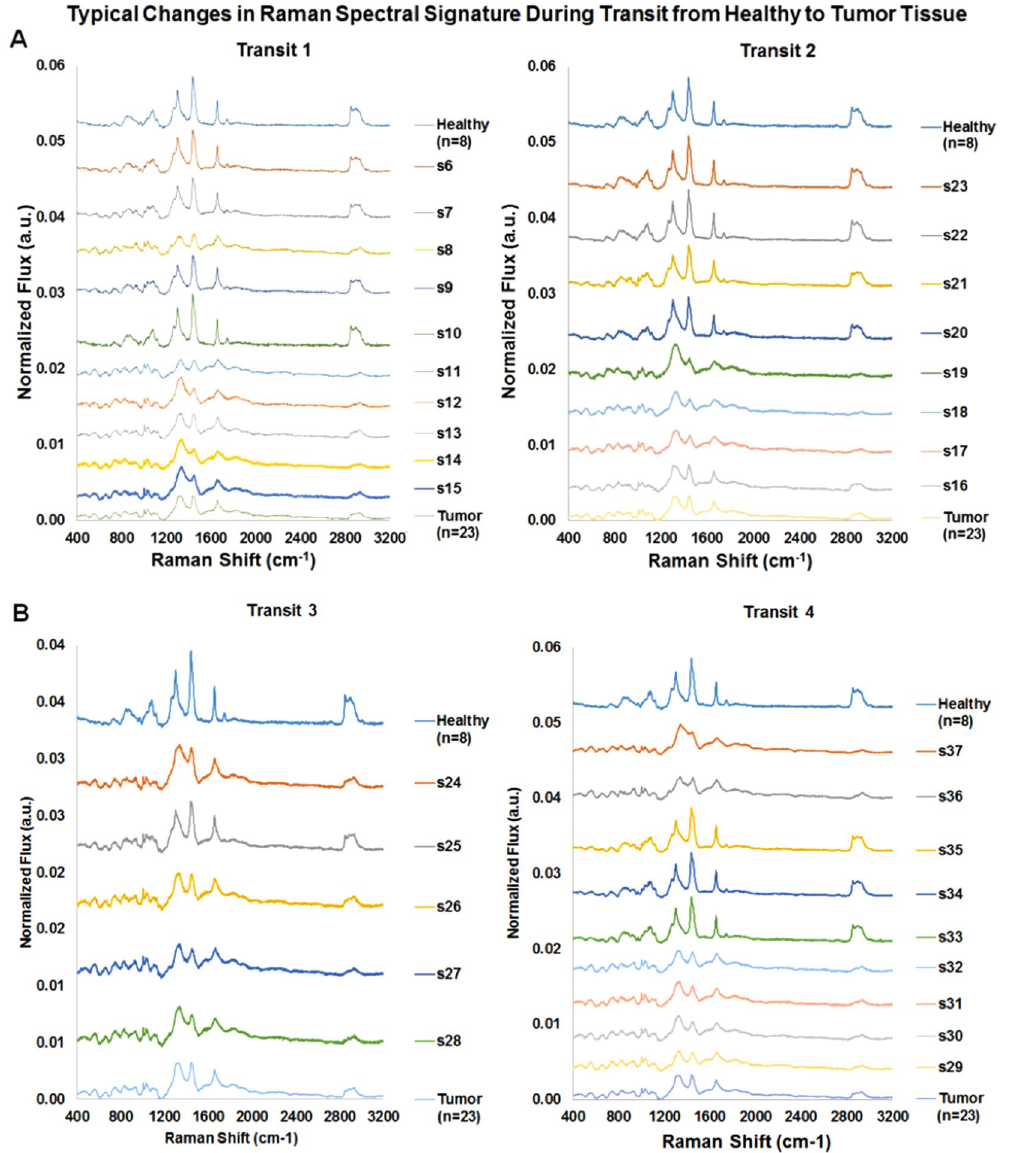
Figure 6. Typical Changes in Raman Spectral Signatures during multiple data collection transits from healthy tissue to tumor tissue. A series of Raman spectra were obtained at ~1 mm intervals along a straight line moving from healthy to tumor tissue (or vice-versa). Such a series was termed a “transit”. By definition, each transit crosses the boundary between the two regions. Raman spectra for tissue sites along four transits are depicted. Each spectrum is the average of three scans, each with an integration time of 30 seconds. Total laser exposure time for each sample is 90 seconds. XY-coordinates for target location are recorded using the microscope micrometer. Spectra identifiers refer to target site designations depicted in Fig. 5. Spectra are numbered in temporal order of collection. For ease of viewing, spectra in Fig. 5 are offset and ordered (from top to bottom of the page) from data collected in putatively healthy tissue, across a boundary region, and then on into a tumor- rich region. For reference, the average spectra obtained from healthy (n = 88) and cancerous (n = 23) tissues, are depicted at the top and bottom, respectively, for each transit. Spectra s1-s5 were collected prior to first transit to evaluate signal/noise characteristics and are discussed in the supplemental material. Transit 1 starts with healthy spectra at sites s6 and s7. There is a clearly abnormal signature at s8, followed by a return to healthy spectra at sites s9 and s10. A clear shift to neoplastic spectra starts at s11 continuing through s15. Transit 2 starts with neoplastic signatures for sites s16-s19, then shifts to healthy spectra for sites s20-s23. Transit 3 traversed a region that appeared to be a mixture of tumor and healthy tissue in both the visible light and H&E images. All of the spectra (s24 through s28) appear to be a mixture of tumor and healthy signatures. Transit 4 starts in a tumor- rich region with spectra at s29-s32 closely resembling the average tumor spectra. The spectra then changes to a series of healthy tissue signatures at sites s33-s35, and finally shifts back to a tumor signature at sites s36 and